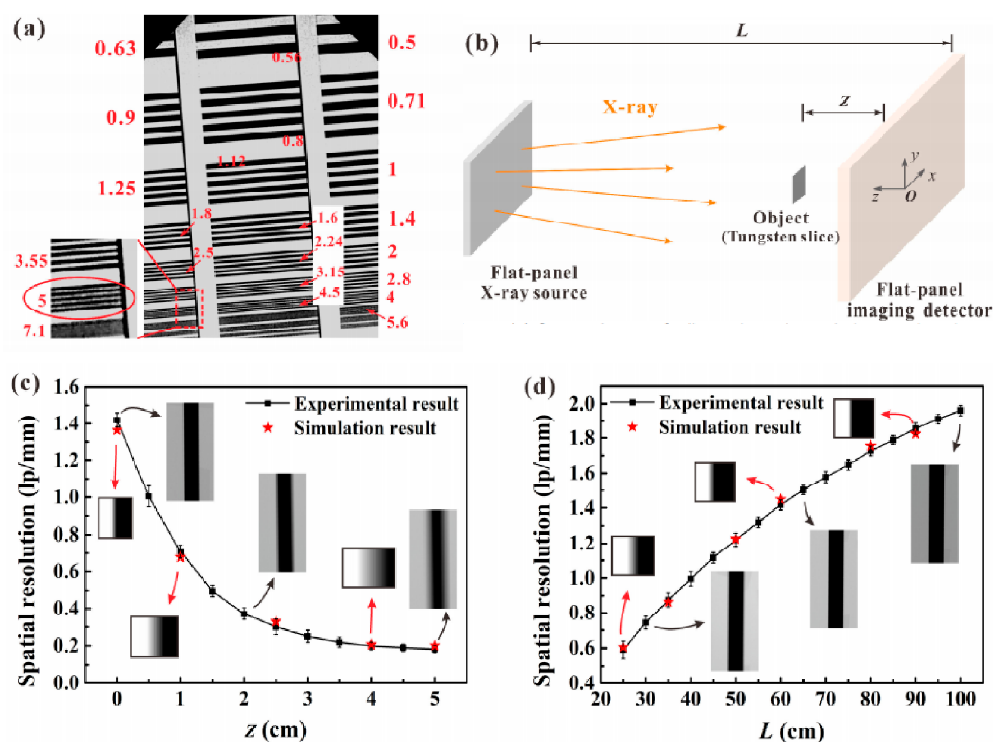
Figure 36. The imaging spatial resolution of a diagonal 4-inch X-ray source based on ZnO nanowires. ( a ) Contact image of a line-pair card. ( b ) Schematic diagram of the testing system. Dependence of spatial resolution on z ( c ) and L ( d ). Reproduced from [61], with the permission of IEEE, 2021.